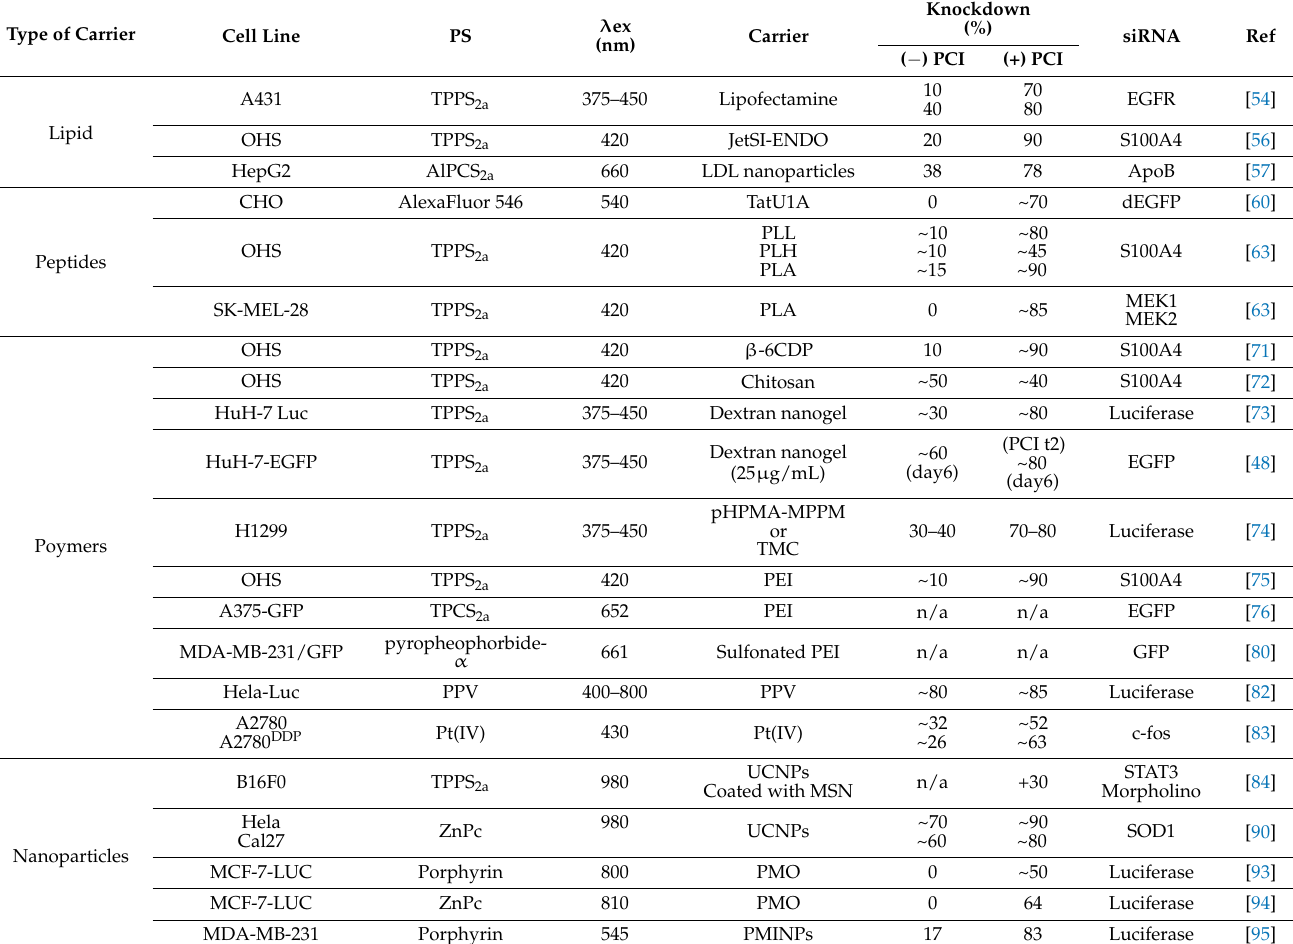
Table 2. Summary of different siRNA carriers able to liberate their cargo by PCI in in vitro